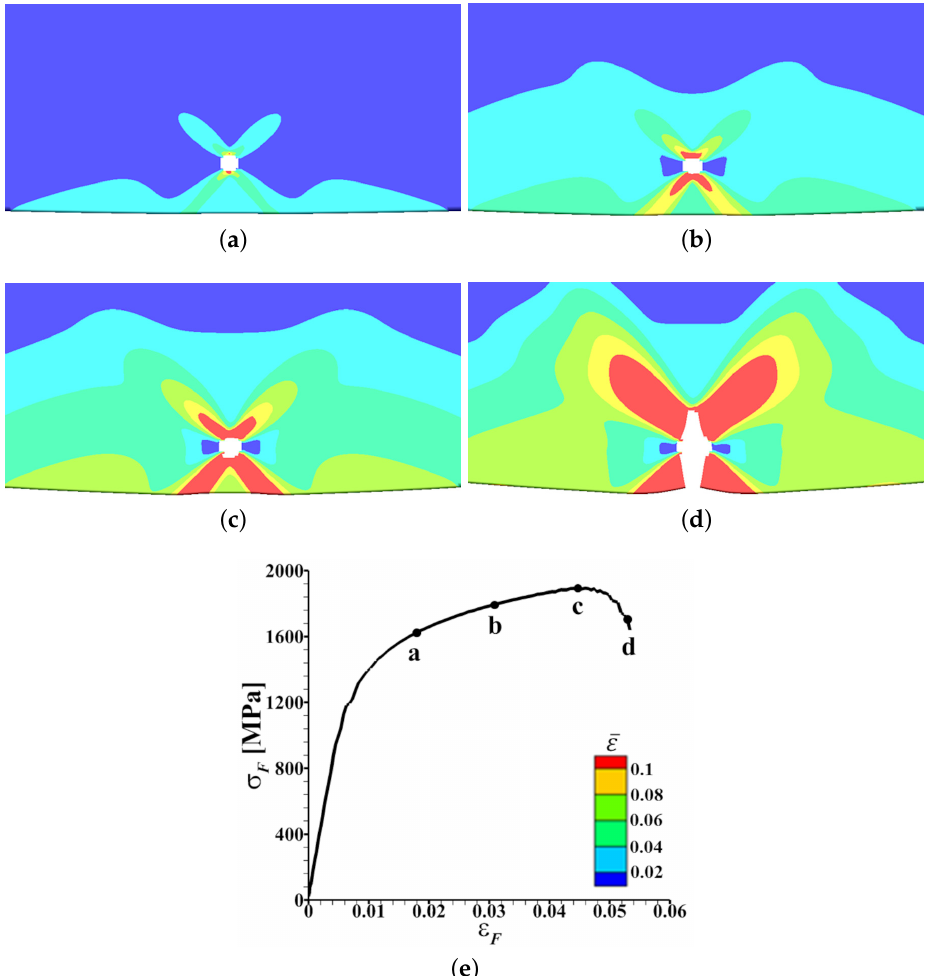
Figure 4. ( a – d ) The distribution of equivalent plastic strain, ¯ ε , in the near surface region on the tension side of a deformed 90 ◦ V-bend specimen of a single-phase material with an inclusion of size, r I ≈ 3 e , strength, σ N = 300 MPa ( σ N / σ 0 ≈ 0.5) and location, dy / d = 0.125, at four macroscopic flexural strain, ε F , levels marked as, a - d , on the macroscopic flexural stress ( σ F )- ε F curve in ( e ).